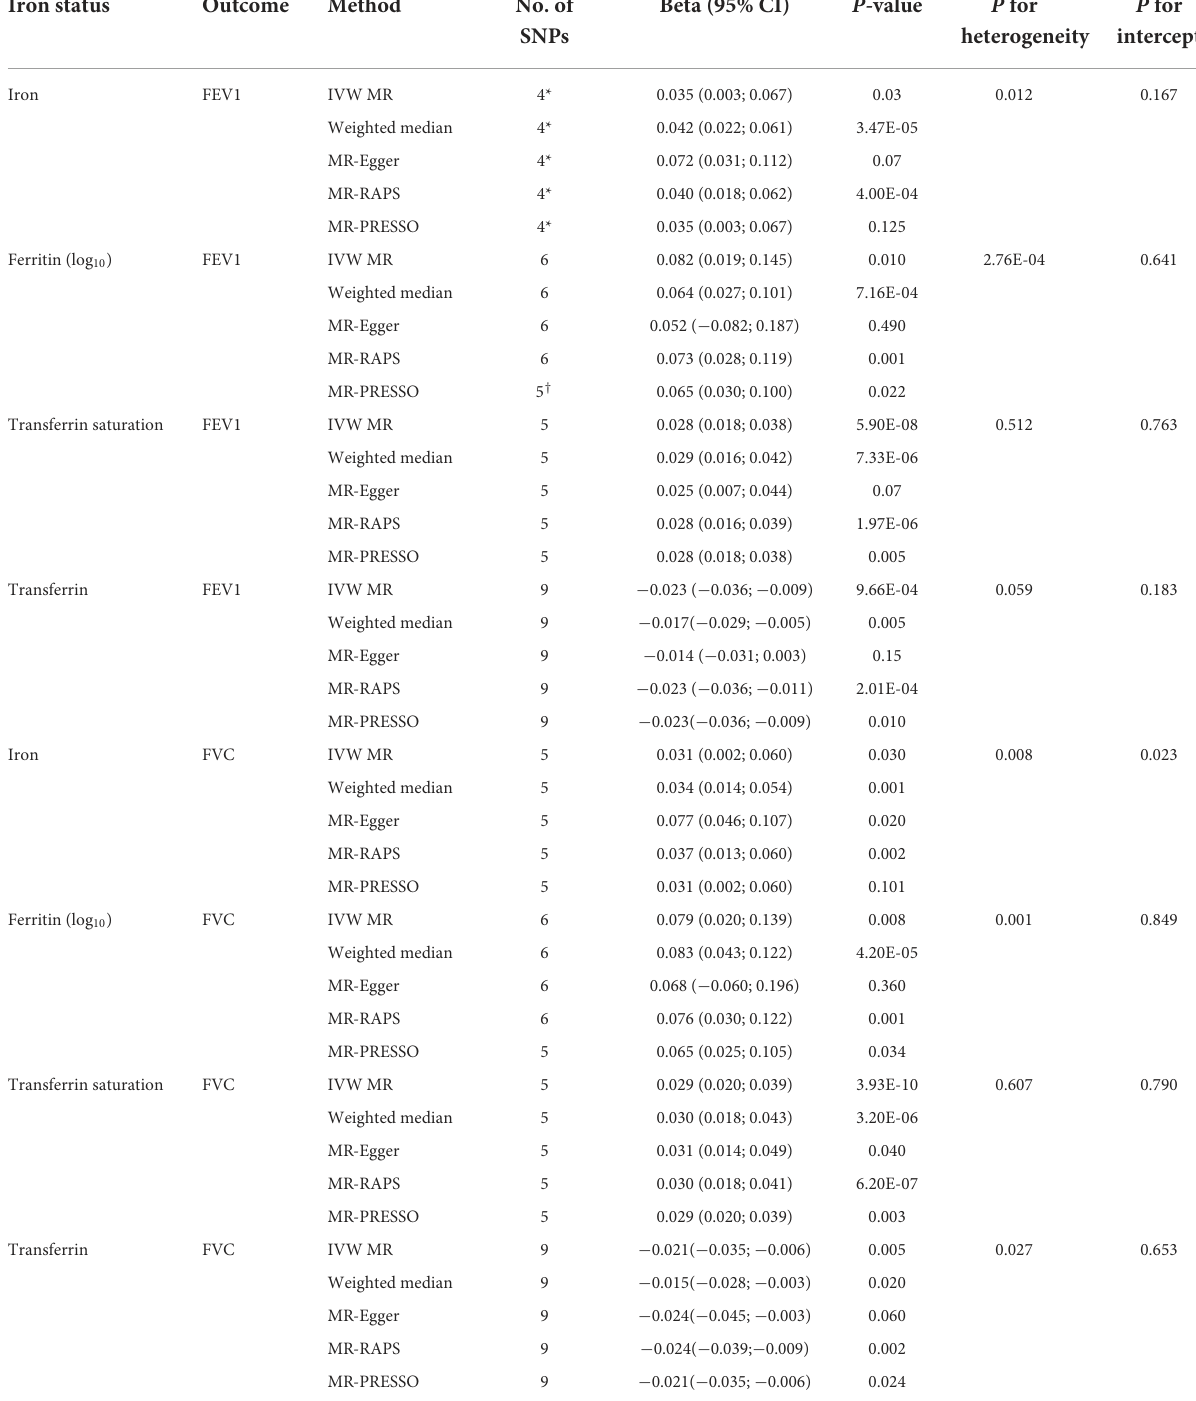
TABLE 3 Associations of genetically predicted iron status with FEV1 and FVC using the separately selected SNPs associated with each iron biomarker. Iron